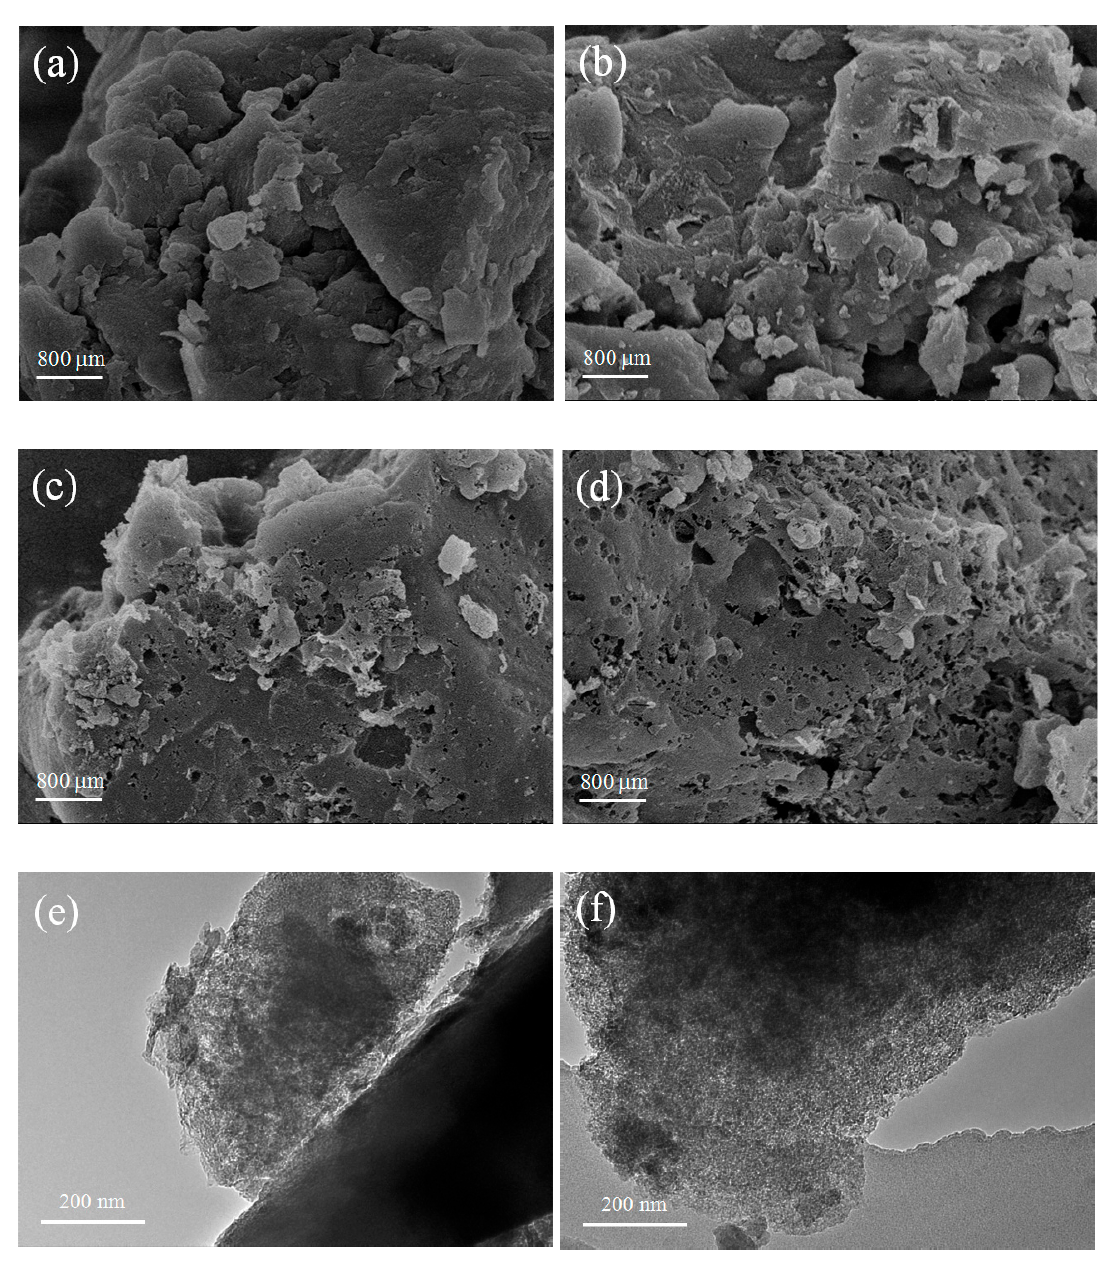
Figure 1. SEM images of Taixi anthracite (TXA) and activated carbons (ACs): ( a ) TXA; ( b ) AC I ; ( c ) AC II ; ( d ) AC III ; ( e ) and ( f ) TEM image of AC III .